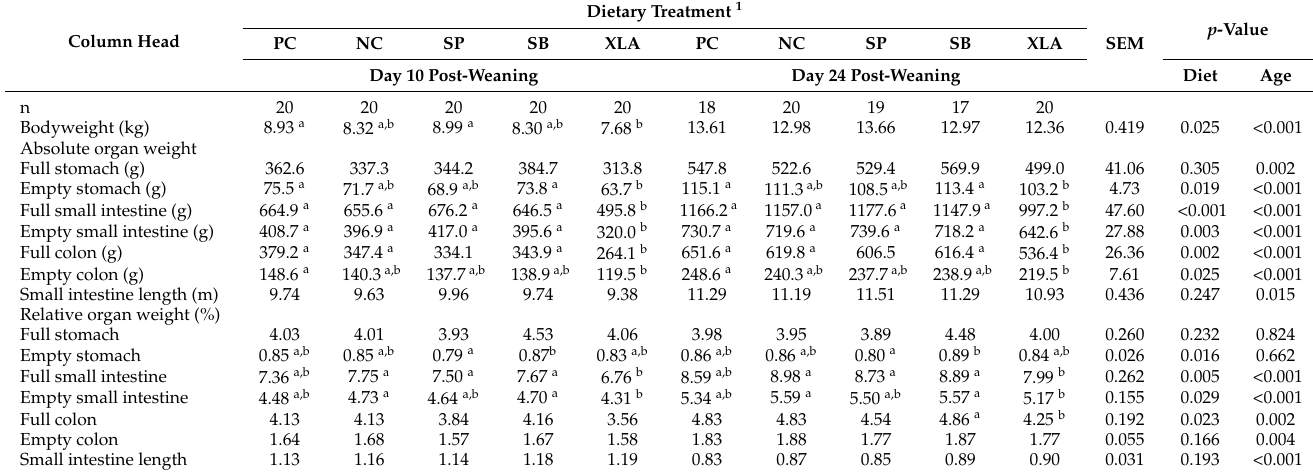
Table 6. Effect of dietary treatment on organ weights at day 10 and 24 post-weaning in dietary